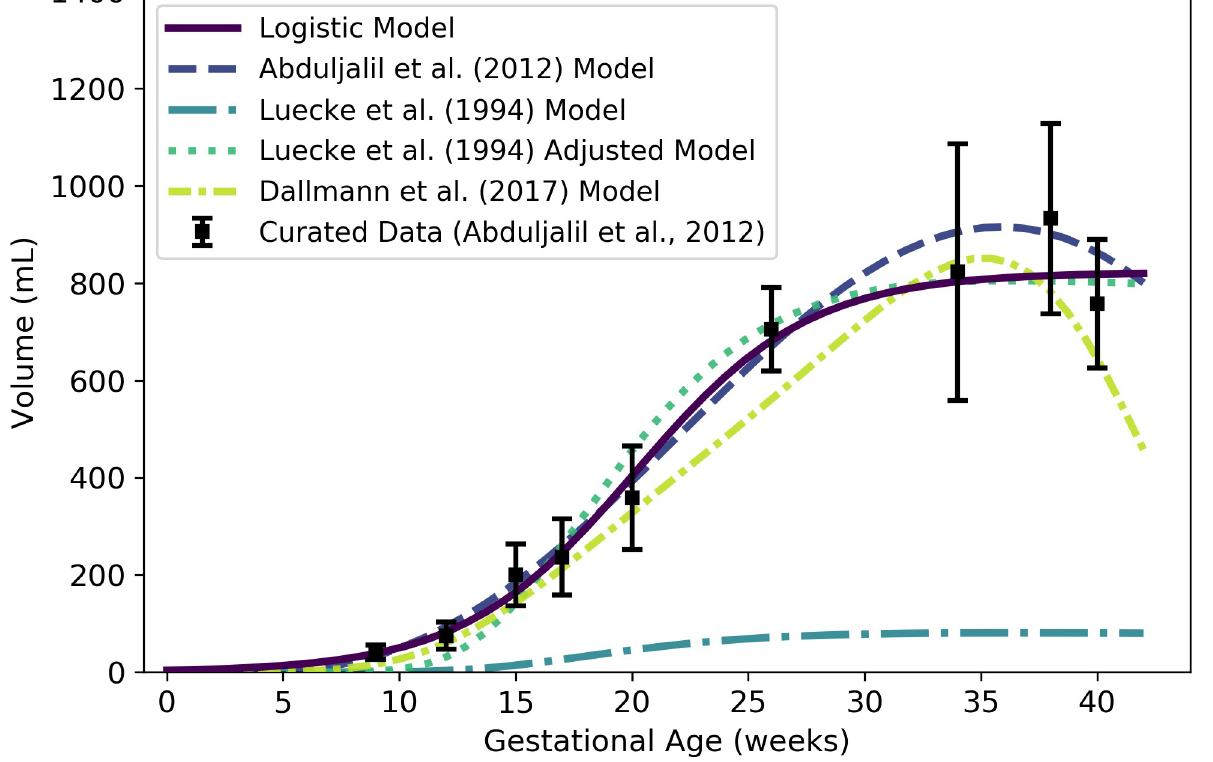
Fig 7. Amniotic fluid volume vs. gestational age. The logistic model (solid line) given by Eq 9 was selected as the most parsimonious model in our analysis. The model of Abduljalil et al. [28], which is a fifth degree polynomial model, was calibrated using the same curated data set [28] used by us. The model of Luecke et al. [15] was calibrated using different data and assumes a relationship between amniotic fluid volume and fetal mass. That model is shown here both as originally stated (in the publication) and after correcting a presumed error (to obtain the “Adjusted Model”) as described in the text. Dallmann et al. [3] calibrated their fourth degree polynomial model with different